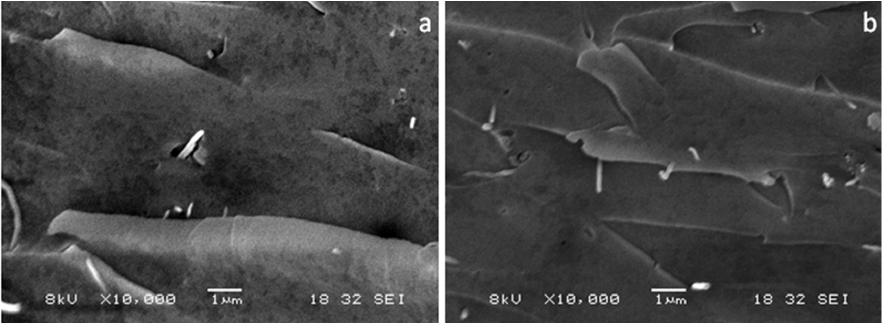
Figure 13. TEM micrographs of sub critical point of the crack initiation site of D-clay ( a , b ) and V-clay ( c , d ) epoxy